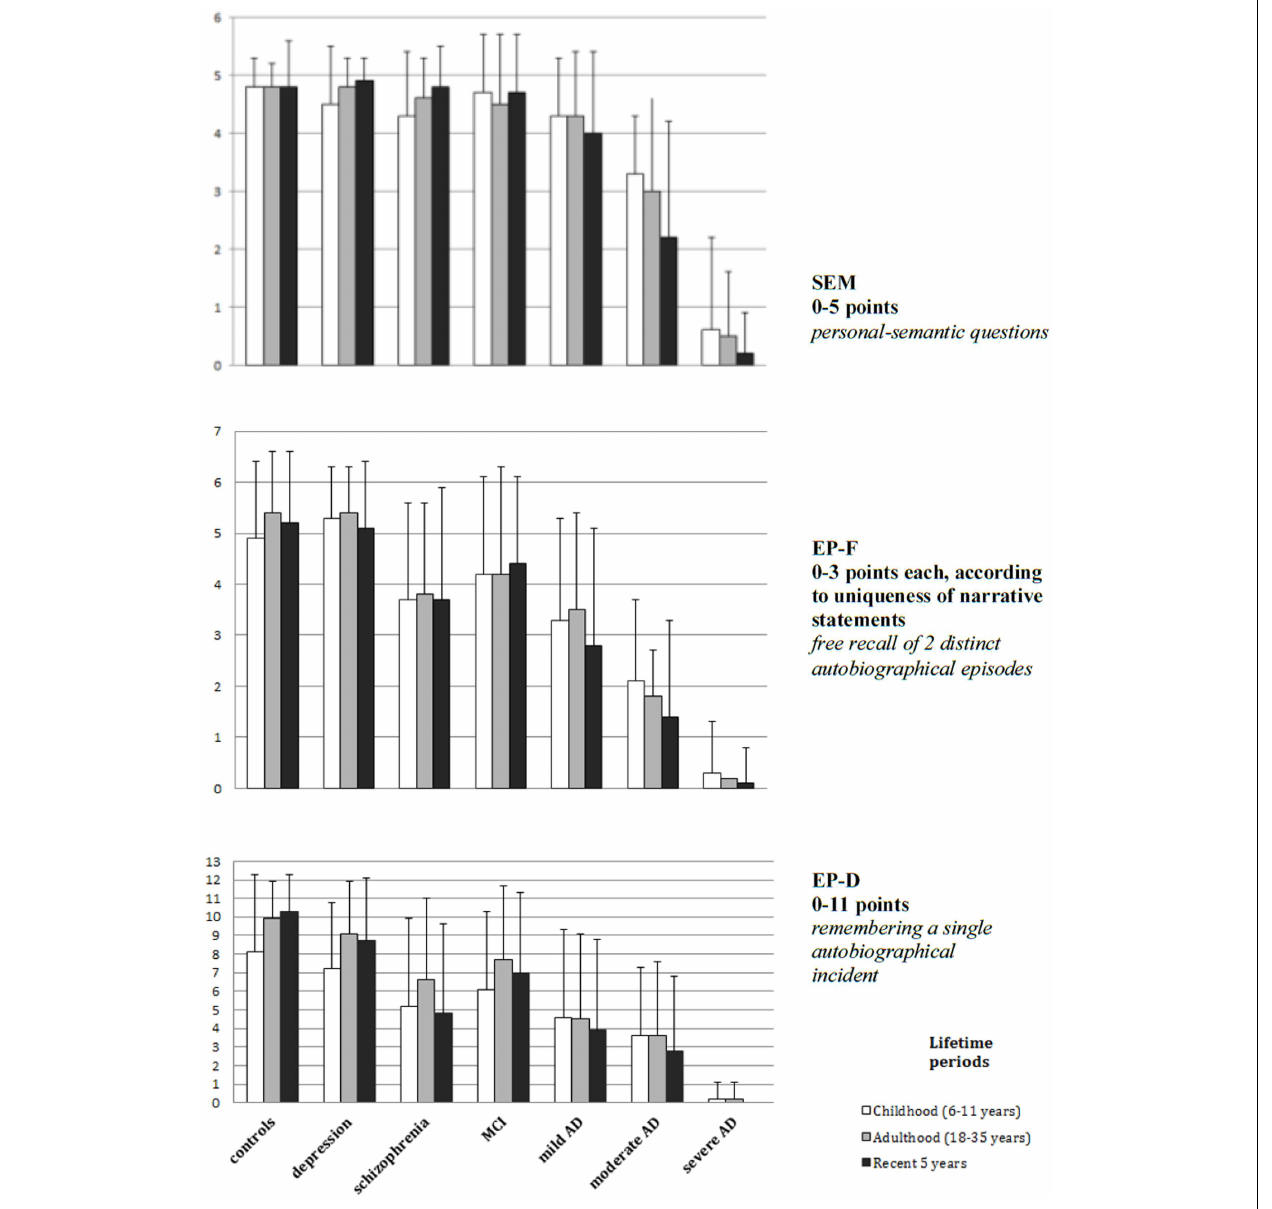
FIGURE 1 | Group comparison concerning semantic knowledge (SEM), free recalled episodes (EP-F) and episodic details (EP-D) by groups of patients with depression (Ahlsdorf, 2009), schizophrenia (Herold et al., 2013), MCI, different stages ofAD and healthy controls (Seidl et al., 2011) .